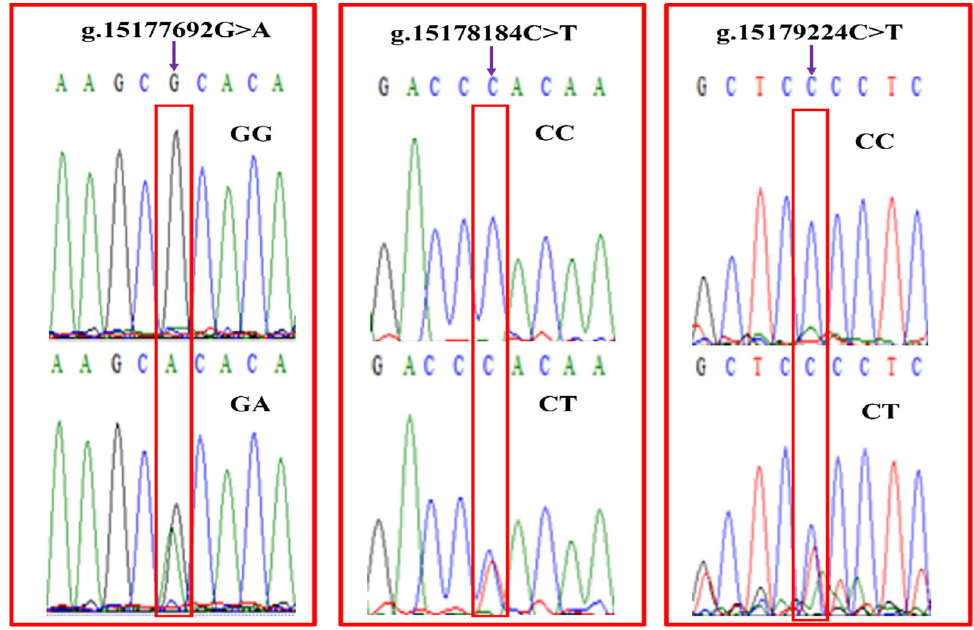
Figure 1. Sequencing profiles around three mutation loci in the HOXC8 of Dezhou donkeys. The upper panels represent the reference genome, and the lower panels represent the variant.